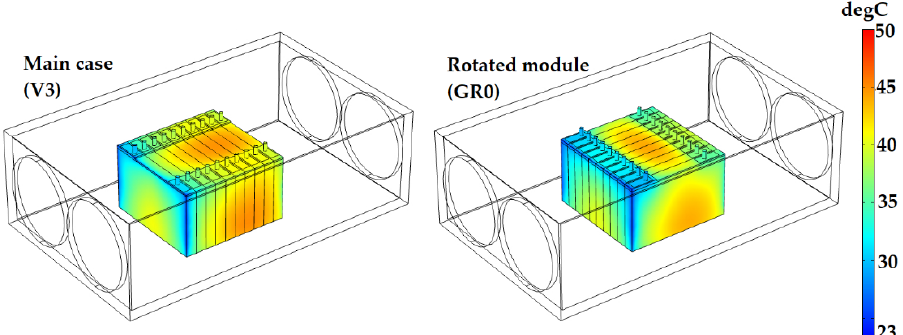
Figure 13. Temperature distribution of the LiC module for various gap spacings between the neighboring LiCs.